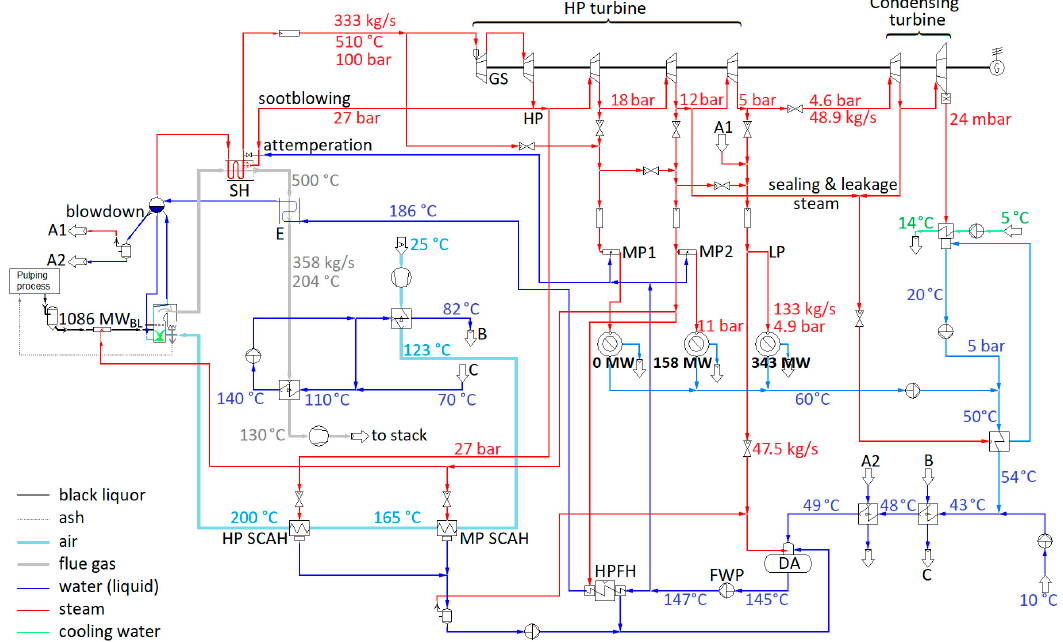
Figure 3. Flowsheet model of the base case D (dry heat recovery). GS—governing stage; HP—high pressure; MP—medium pressure; LP—low pressure; HPFH—high-pressure feed heater; DA—deaerator; SCAH—steam coil air heater; SH—superheater;